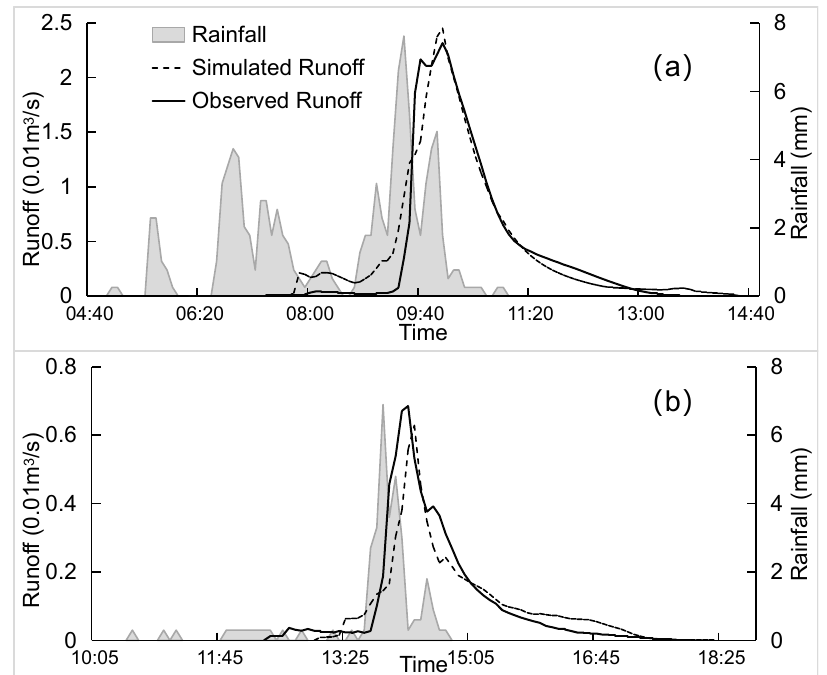
Figure 3. The calibration ( a ) and validation ( b ) of SWMM using the observed storm rainfall event.